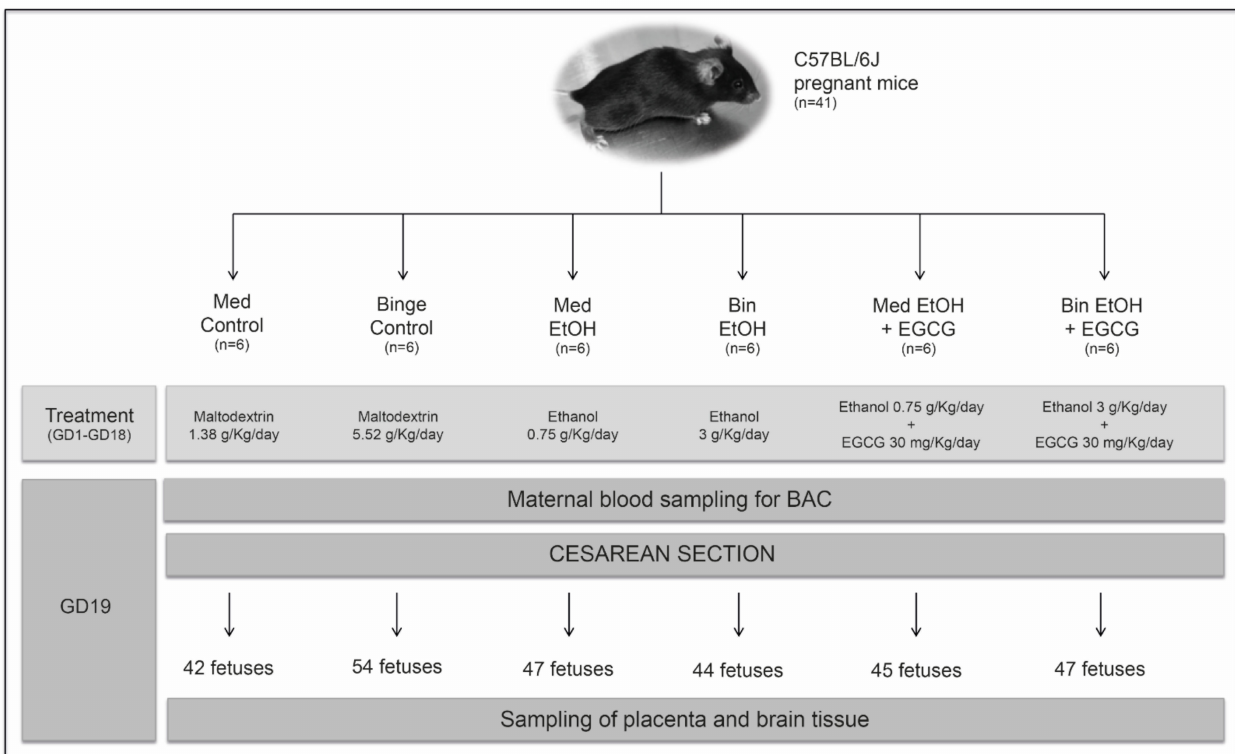
Figure 10. Flowchart of the experimental design. Sample size and doses of maltodextrin, alcohol, and epigallocatechin-3- gallate are specified for each experimental group. Maternal blood sampling to determine blood alcohol concentration and birth by cesarean section were obtained on gestational Day 19. The gestational period of the mice corresponds to the first and second human equivalent. EtOH: ethanol; Bin: binge; Med: Mediterranean; EGCG: epigallocatechin-3-gallate; GD: gestational day; BAC: blood alcohol